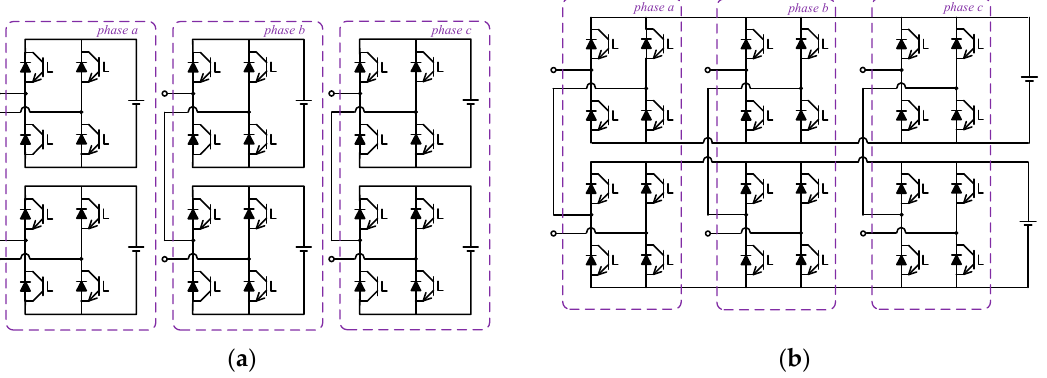
Figure 2. Structural comparison between topologies: ( a ) classical multilevel cascaded H bridge converter (CHB) topology; ( b ) proposed CHB-single DC (SDC) topology [9].